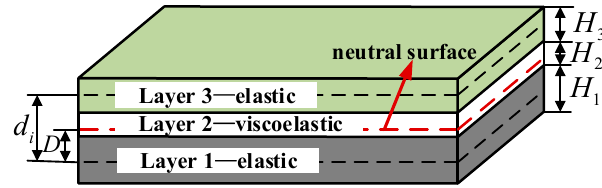
Figure 1. Section sketch map of a sandwich beam specimen.